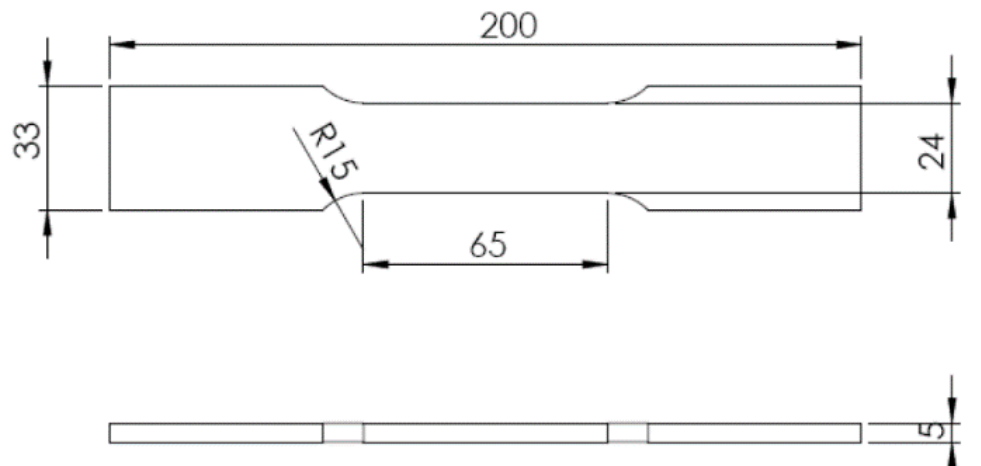
Figure 5. The schematic diagram of test specimen (aluminum6061-T6, mm).